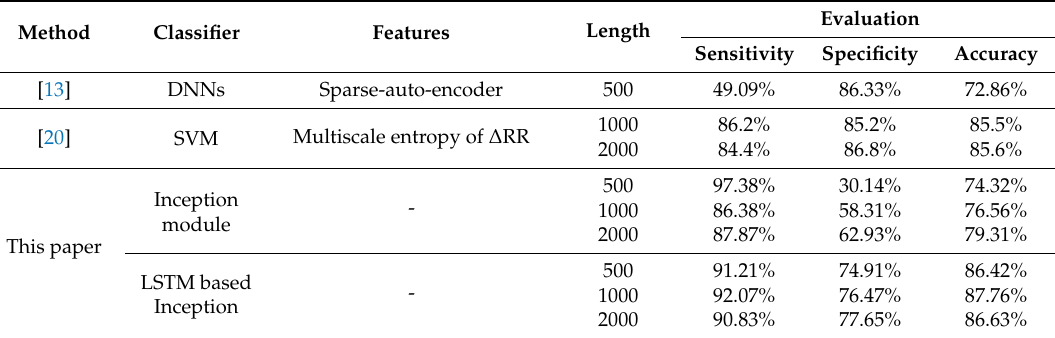
Table 6. Performance of the 10-fold cross-validation